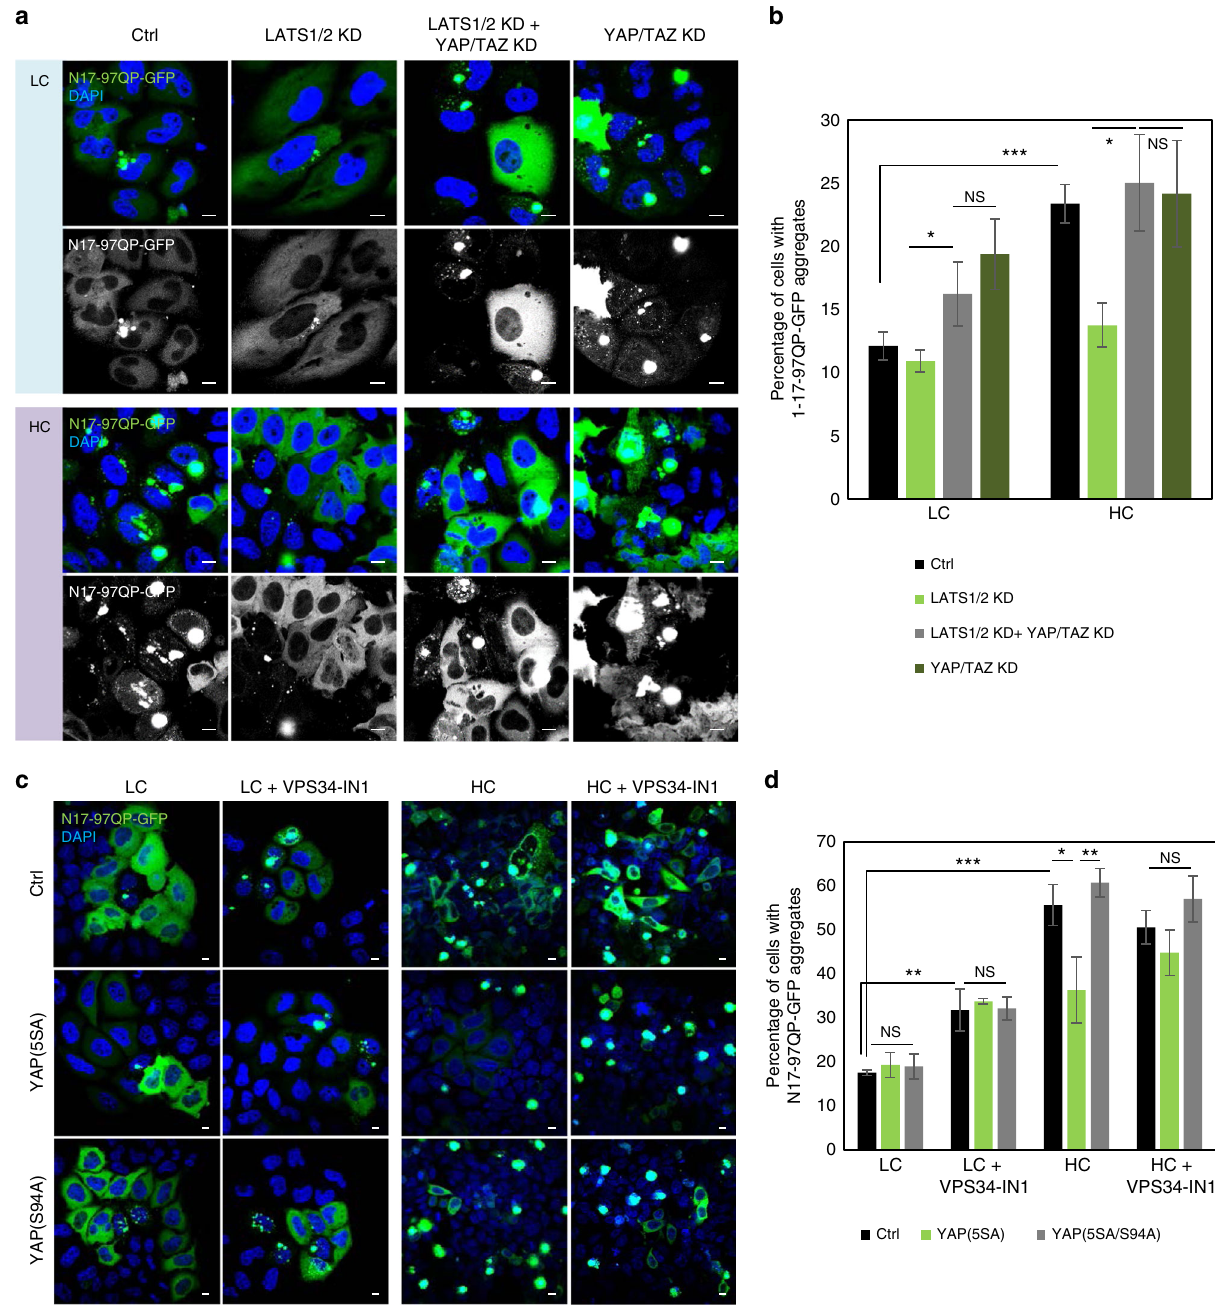
Fig. 6 The accumulation of mutant huntingtin in high con fl uency HeLa cells is YAP/TAZ- and autophagy-dependent. a Representative images of N17- 97QP-GFP aggregates in HeLa cells treated with LATS1/2 and/or YAP/TAZ siRNAs, transfected with N17-Q97P-GFP (1 µ g) and plated at low and high con fl uencies for 48 h. b N17-Q97P-GFP aggregation in HeLa cells treated as in a . Bars represent the mean ± s.d. of one representative experiment performed in triplicates (*** P < 0.001, * P < 0.05, NS, not signi fi cant; two-tailed t -test). The experiment was repeated with similar results. c Representative confocal images of N17-Q97P-GFP aggregates in HeLa cells overexpressing control (empty fl ag vector), YAP(5SA) or YAP(5SA/S94A) were seeded at low and high con fl uencies and exposed to either control (DMSO) or VPS34-IN1. Scale bars are 10 µ m. d Quanti fi cation of the percentage of HeLa cells with at least one N17-Q97P-GFP aggregates. The cells were treated as in ( c ). Bars represent the mean ± s.d. ( n = 3; *** P < 0.001, ** P < 0.01, * P < 0.05; two-tailed t -test). n = number of independent biological replicates unless otherwise